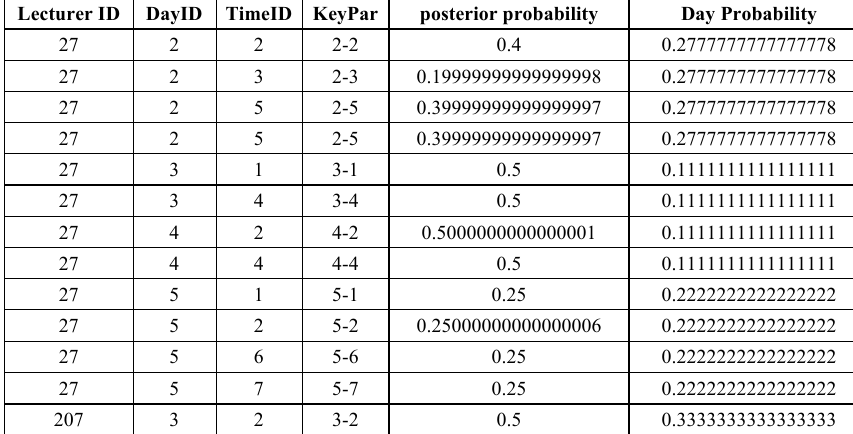
Table 2. : Sample learning